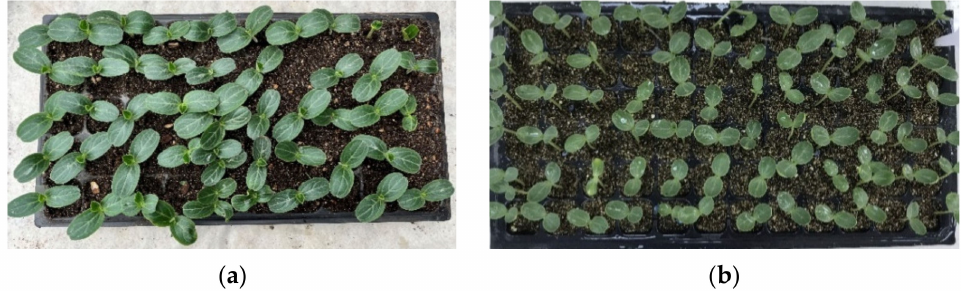
Figure 8. Test materials: ( a ) rootstock seedlings in a greenhouse and, ( b ) scion seedlings in a